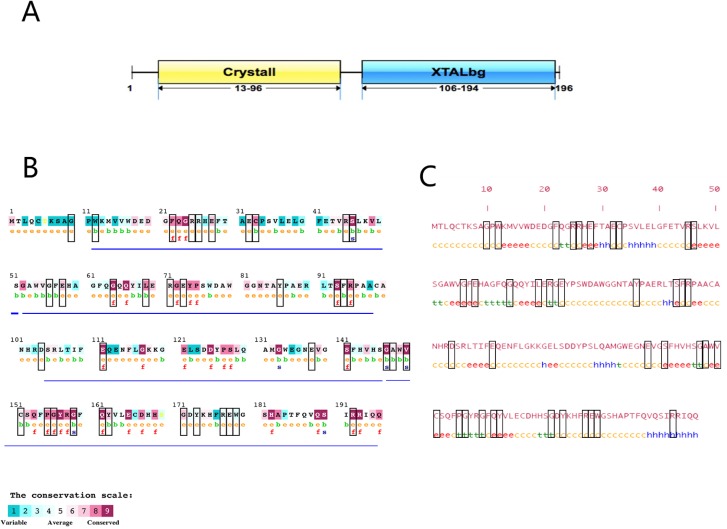
Structural domains, evolutionary conservation and protein structure analysis of CRYBA4 high-risk pathogenic nsSNPs.A. CRYBA4 protein domain. CRYBA4 consists of "Crystall" and "XTALbg" domains. There are 84 amino acids in Crystall domain (from 13th to 96th) and 89 amino acids in XTALbg domain (from 106th to 194th). B. ConSurf software CRYBA4 protein amino acid evolutionary conservation prediction results. The black boxes indicate wild amino acids that would be affected by CRYBA4 high-risk pathogenic nsSNPs. Four motifs are marked as blue underlines. Evolutionary conserved sites get scores between 7 and 9. The letter “e” denotes the exposed residues according to the neural-network algorithm; the letter “b” denotes the buried residues according to the neural-network algorithm; the letter “f” denotes the predicted functional residues (highly conserved and exposed) and the letter “s” denotes the predicted functional residues (highly conserved and buried). C. Prediction of secondary structure of CRYBA4 protein by SOPMA software. The black boxes indicate wild amino acids that would be affected by CRYBA4 high-risk pathogenic nsSNPs. The letter “h” denotes alpha helix; the letter “e” denotes extended strand, the letter “t” denotes beta turn and the letter “c” denotes random coil.